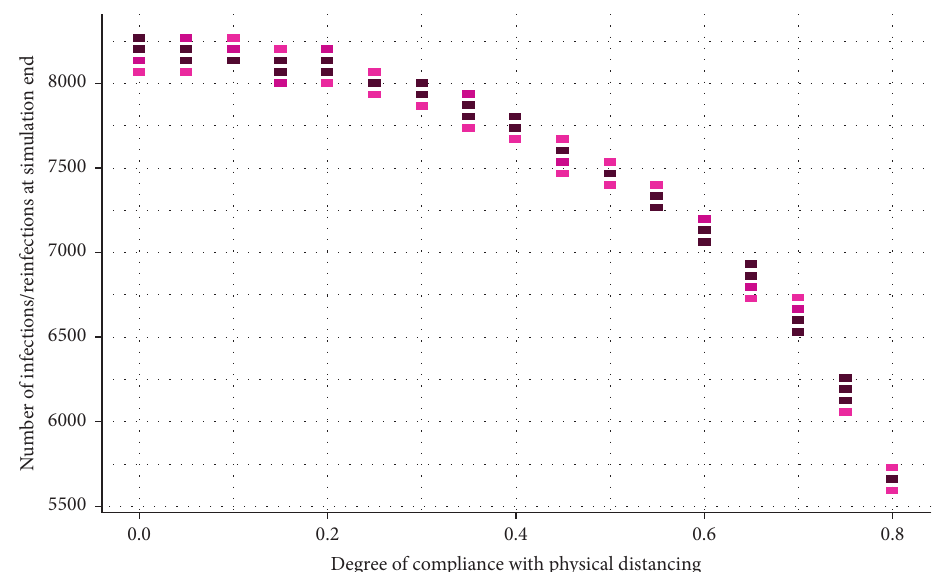
Figure 4: The number of infections against the degree of compliance with physical-distancing requirements (including mask-wearing). Note that the “number of infections” metric includes reinfections, so the score can exceed the number of people in the university (6,500). Numerous runs are binned and the color indicates clustering of runs, with darker colors corresponding to a greater number of